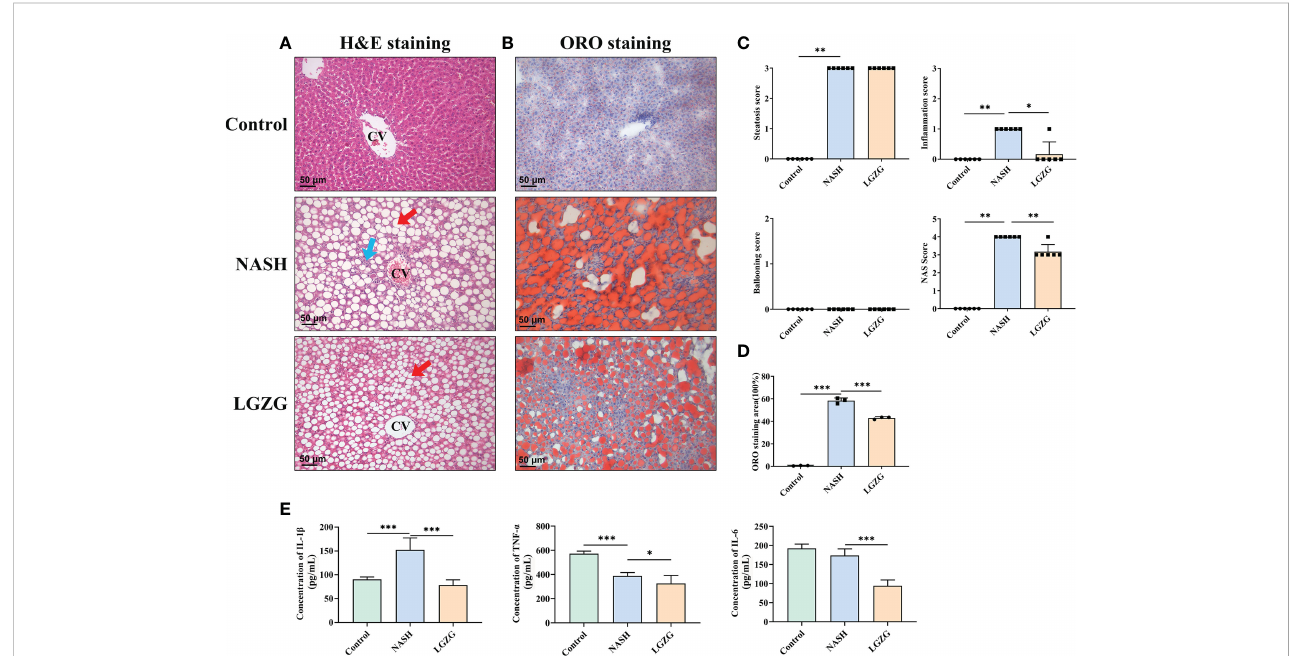
FIGURE 2 LGZG improved lipid droplets, steatosis and in fl ammation in NASH. (A) Hemoxylin & Eosin staining in liver section in the Control, NASH, and LGZG groups, respectively. The red arrow indicates macro-vesicular steatosis, and the blue arrow indicates interlobular in fl ammation (magni fi cation, ×200). (B) Oil Red O staining in the Control, NASH, and LGZG groups, respectively (magni fi cation, ×200). (C) NAFLD activity score (NAS Score) including steatosis, in fl ammation, and ballooning scores. (D) The Oil Red O staining area; data are expressed as the means±SD (*p <0.05). (E) The expressions of pro- in fl ammatory cytokines IL-1 b , TNF a , and IL-6 by ELISA (pg/mL). Data are presented as the mean ± SD (*p < 0.05; ** p<0.01; ***p <